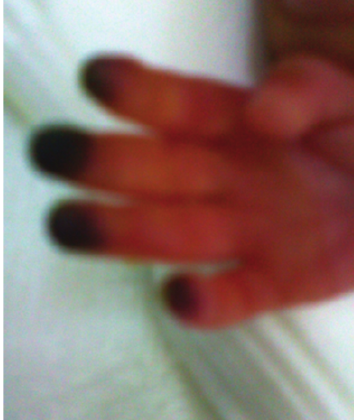
Figure1:Digitalinvolvementoftherighthand8hoursafterbrachial artery cannulation.